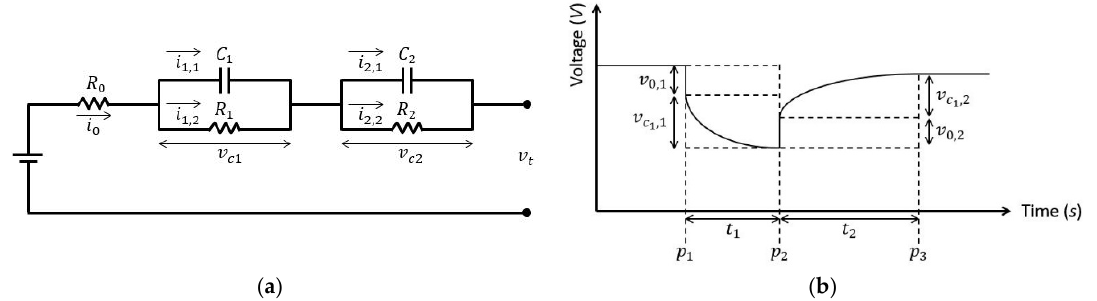
Figure 8. Battery modeling; ( a ) two-ladder battery equivalent circuit model (ECM); ( b ) impedance voltage response.